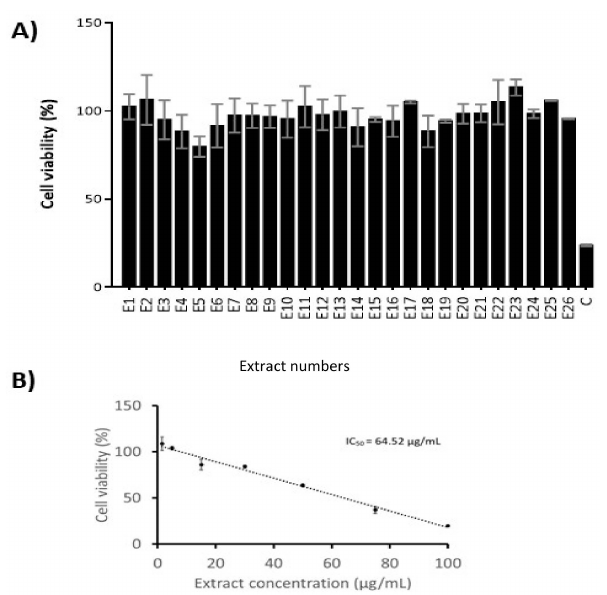
Figure 2. ( A ) The viability of MDA-MB-231 cells exposed to Plectranthus spp. extracts (15 µ g / mL) for 48 h assessed by the crystal violet staining assay using doxorubicin (DOX, 5 µ M) as positive control; ( B ) Concentration-response profile for the P. madagascariensis extract obtained by maceration in acetone. Results are expressed as mean ± standard deviation (SD) from at least two independent experiments. IC 50 : extract concentration producing 50% inhibition of cell